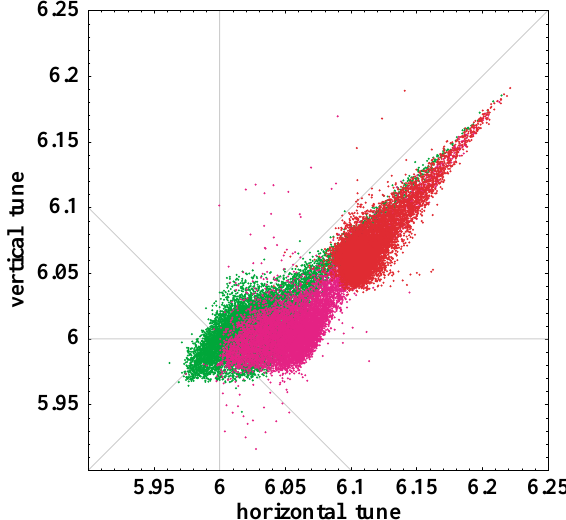
FIG. 12. (Color) Vertical rms emittances during the multiturn injection process for three final intensities: N (cid:1) 2 3 10 14 (solid red curve), N (cid:1) 3 3 10 14 (short-dashed, pink curve), N (cid:1) 4 3 10 14 (long-dashed, green curve), in the absence of magnet errors. SNS working point (cid:3) n 0 x , n 0 y (cid:4) (cid:1) (cid:3) 6.23, 6.20 (cid:4)